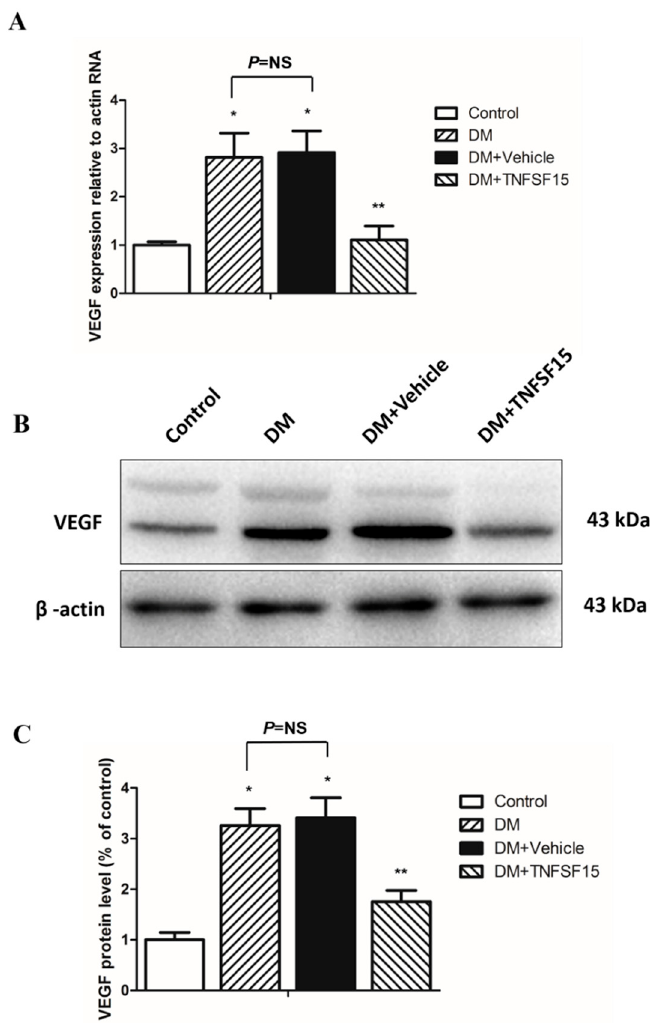
Figure 6. VEGF expression decreased in the retina of diabetic rats treated with TNFSF15. ( A ) RT-PCR analysis for VEGF mRNA in retinal tissue. Data are shown as the mean ± SD. ANOVA (one-way) followed by the LSD test. * p < 0.001, significantly different from the control group; ** p < 0.001, significantly different from the DM group; NS = nonsignificance; ( B ) A representative Western blot image is shown; ( C ) Image of a Western blot analysis is shown: the data are shown as a percentage of the control and are presented as the mean ± SD of eight eyes. ANOVA (one-way) followed by the LSD test. * p < 0.001, significantly different from the control group; ** p < 0.001, significantly different from the DM group; NS = nonsignificance.